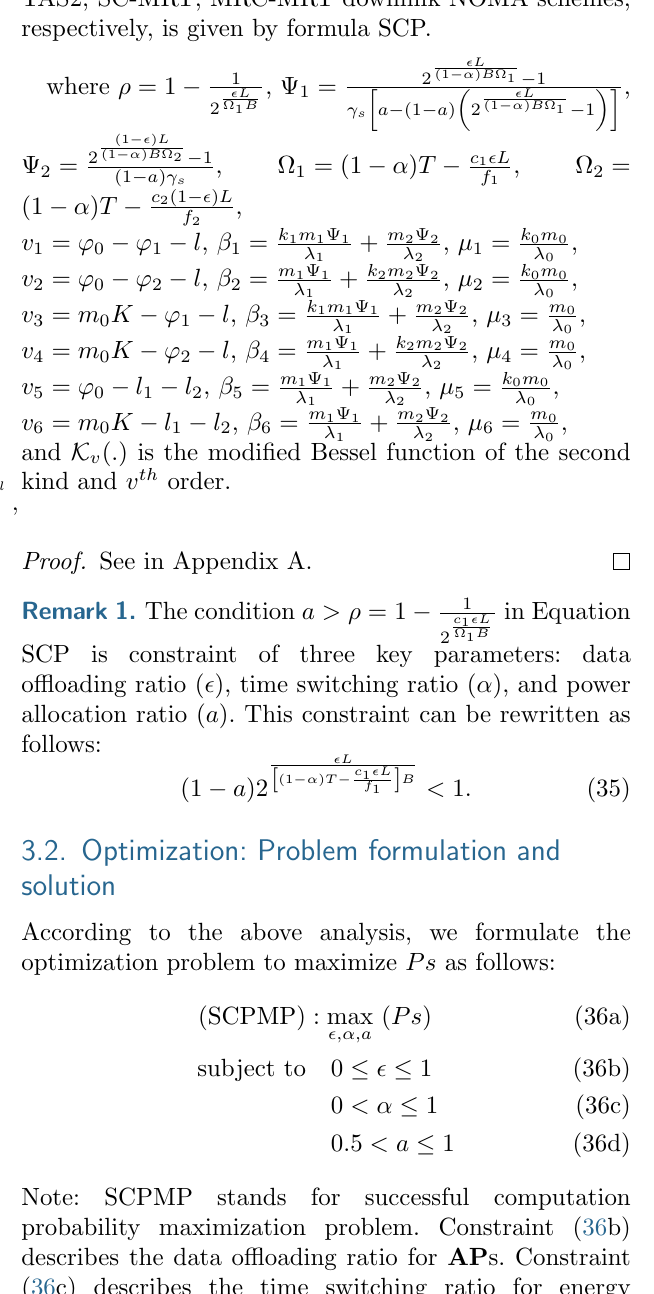
Algorithm 2 - SCPMS and Algorithm 3 - SCPMG